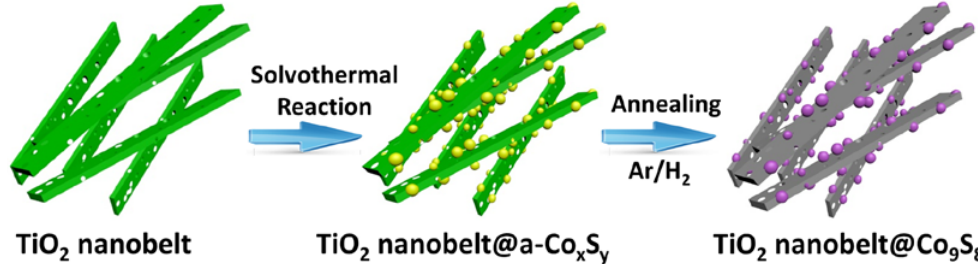
Figure 1. Preparation process of TiO 2 nanobelt@Co 9 S 8 composites.